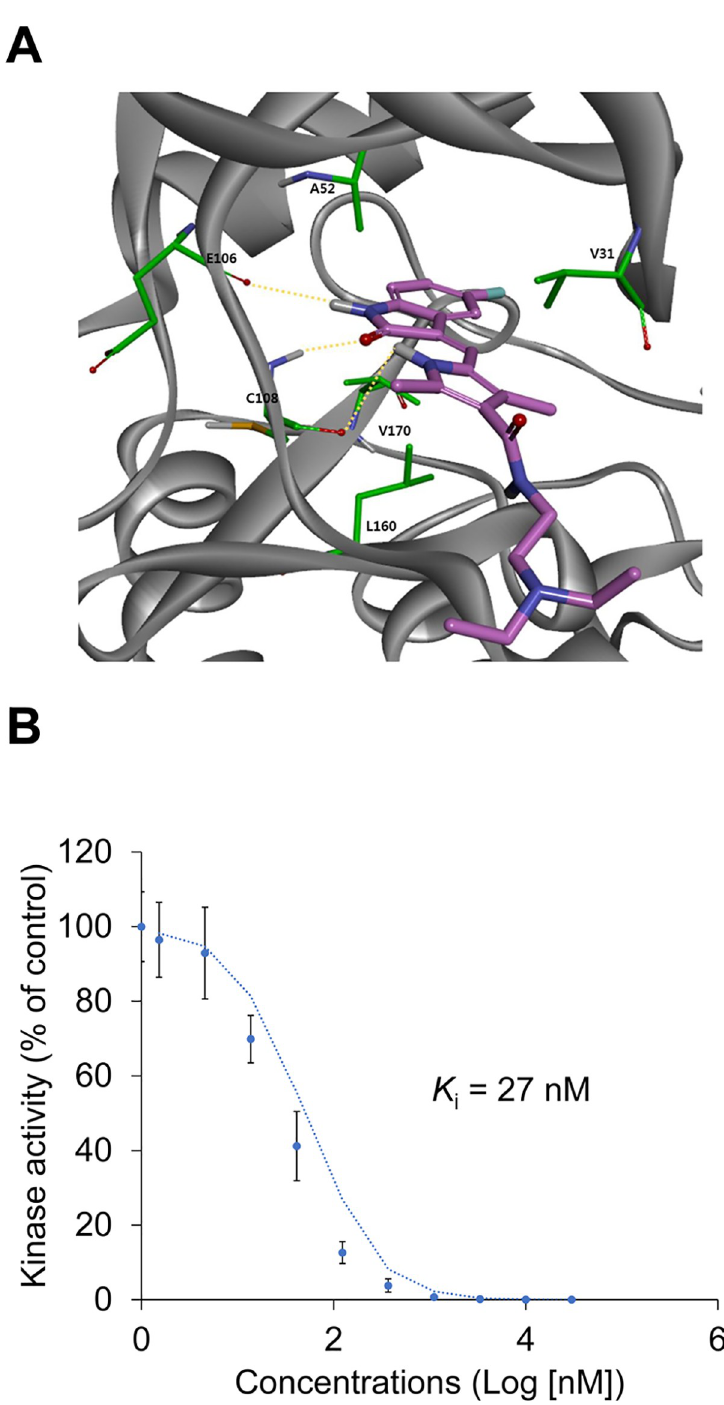
Fig 1. Binding mode and K i of sunitinib for TNIK. (A) The proposed binding mode of sunitinib (pink) in the ATP- binding pocket of TNIK. TNIK and its interacting residues are represented by ribbons and sticks, respectively. Hydrogen bonding interactions appear as dashed yellow lines. (B) The binding constant, K i , of sunitinib for TNIK was determined using an ATP competition assay.